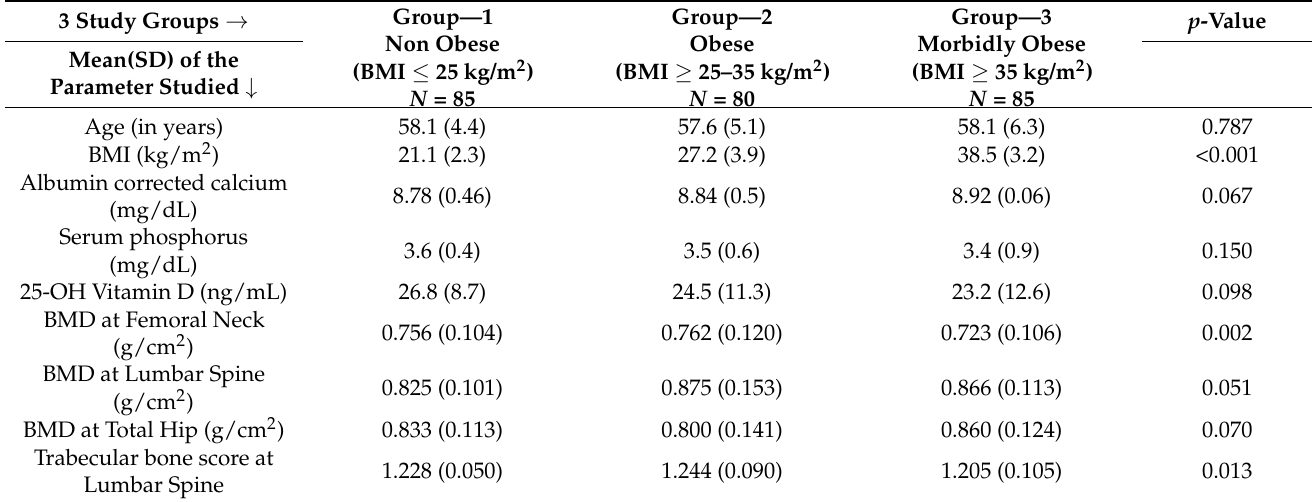
Table 1. The demographic details and bone mineral parameters in the three